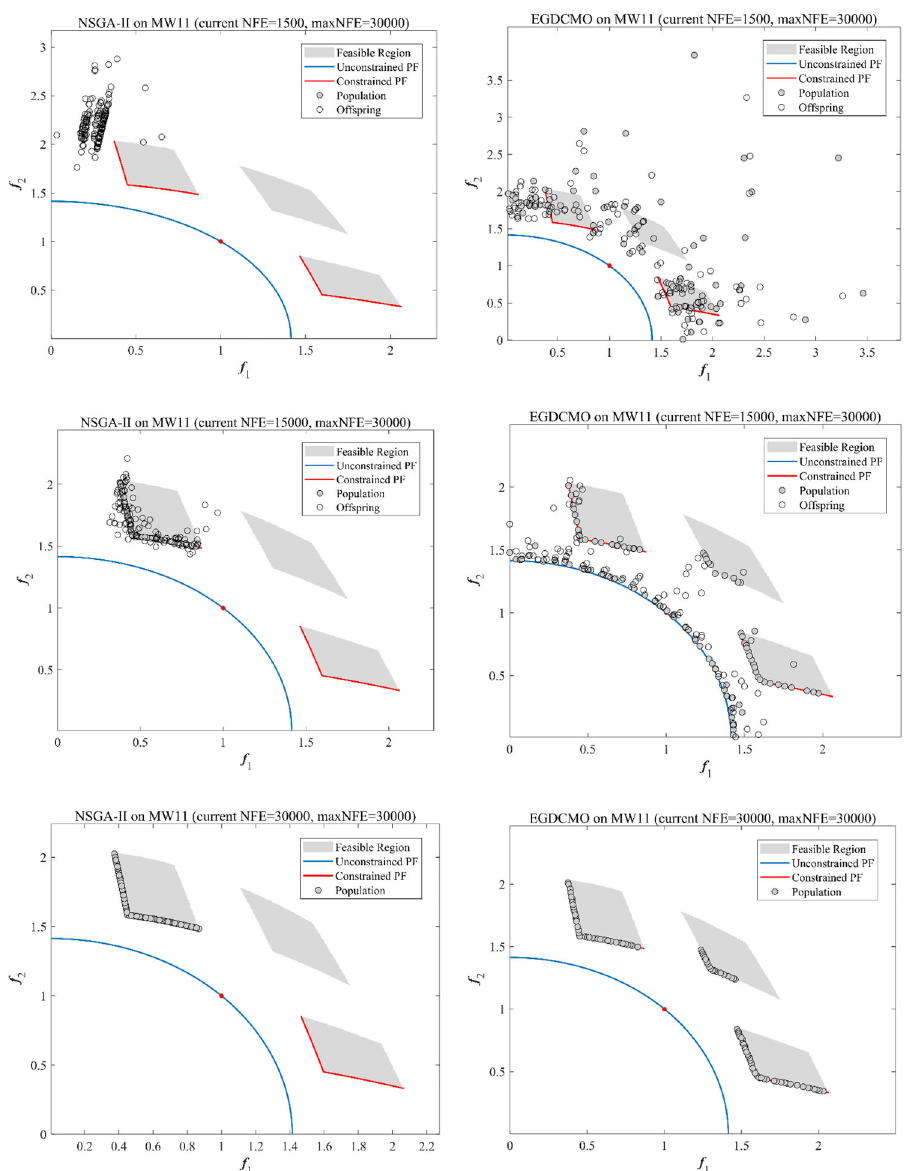
Fig. 5 Populations in the early, middle, and last generations